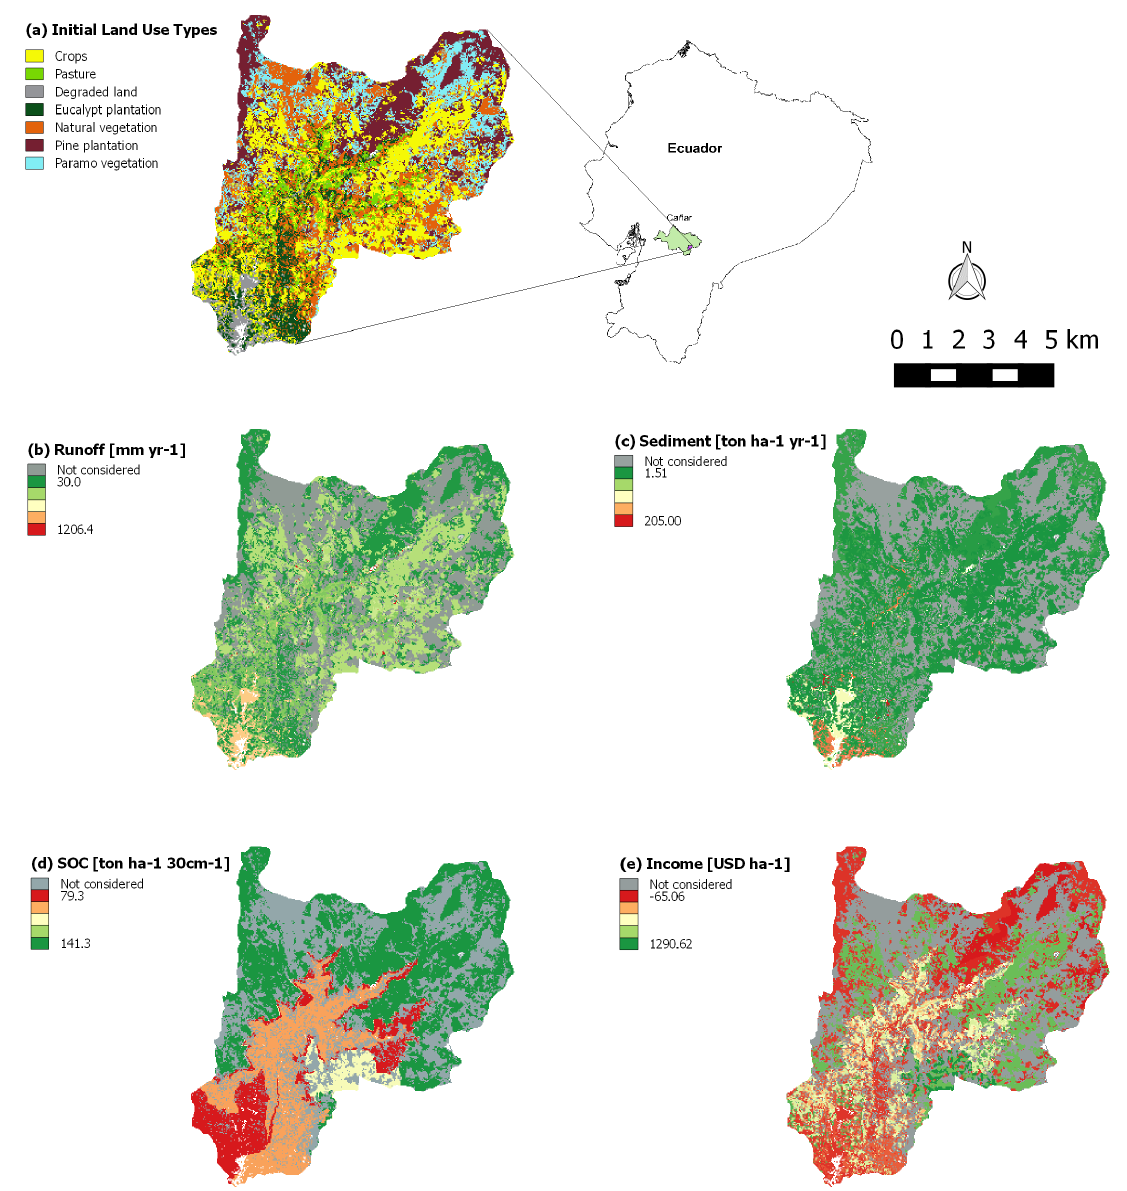
Figure 1. ( a ) Initial (year 0) land use type distribution and location in Ecuador of the Tabacay catchment; and its initial environmental performance expressed in terms of ( b ) Runoff production; ( c ) Sediment production; ( d ) Soil Organic Carbon (SOC); and ( e ) Monetary income. The areas under páramo and natural vegetation were excluded from the study (see Section 3.2). These areas are displayed in gray in maps ( b – e